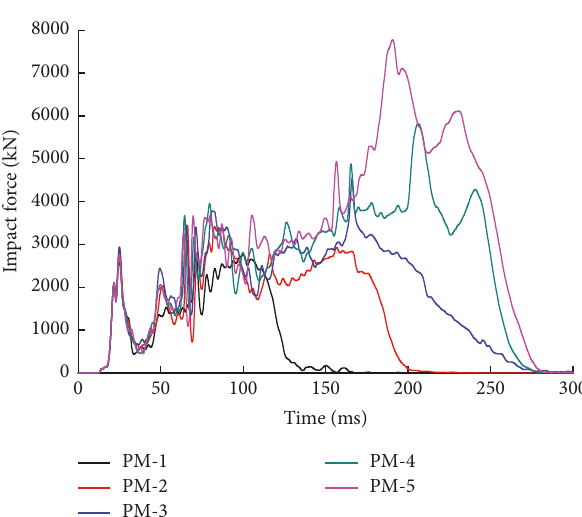
Figure 16: Impact force time-history curves under different impact velocities.